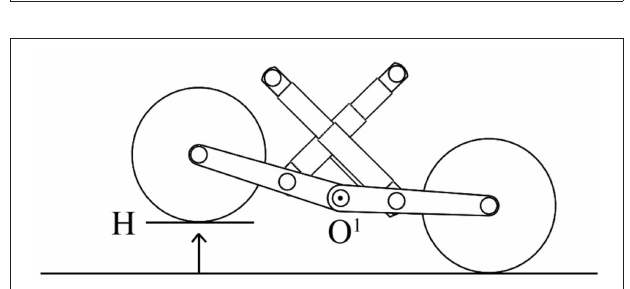
FIGURE 3 | Single-arm suspension linkages with shock absorbers.